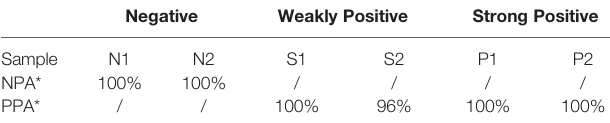
TABLE 4 | Precision.